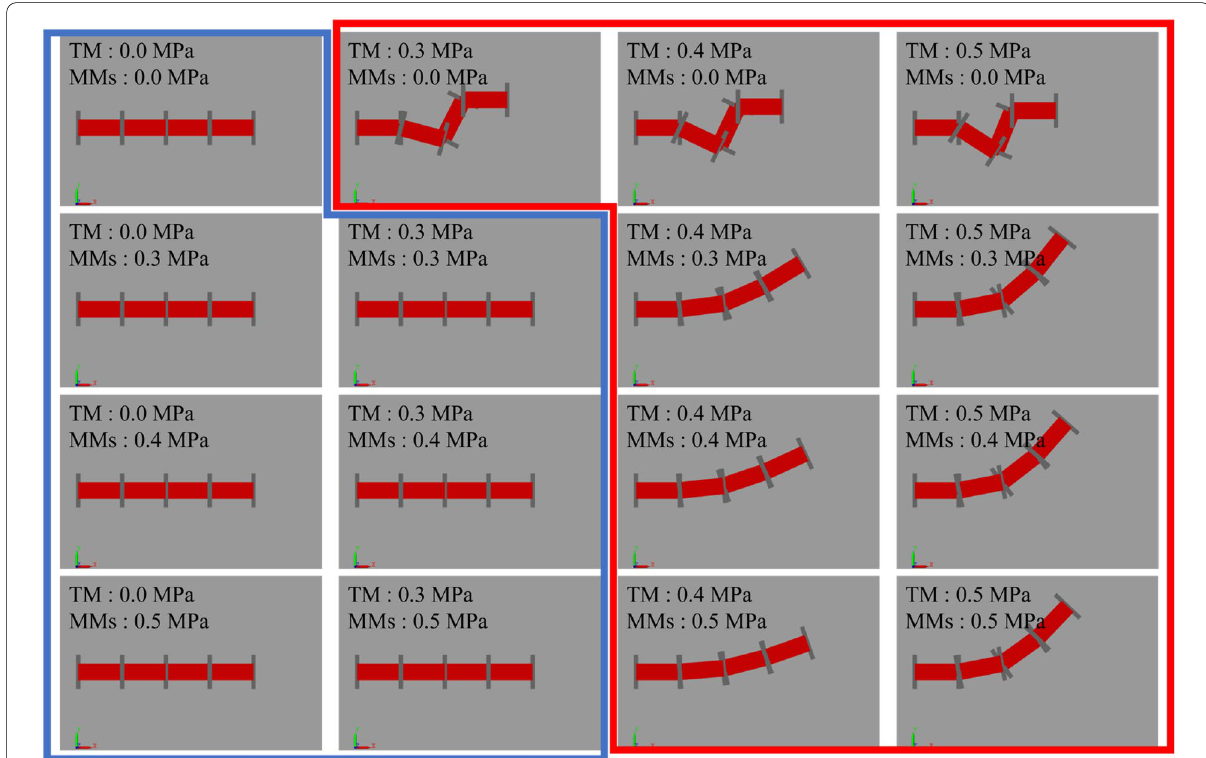
Fig. 5 Results of dynamic simulations. One spring representing a tri-articular muscle (TM) is attached to both ends of the system, and three springs representing monoarticular muscles (MMs) are attached around each joint. Note that all the MMs are driven by the same pressure at each condition